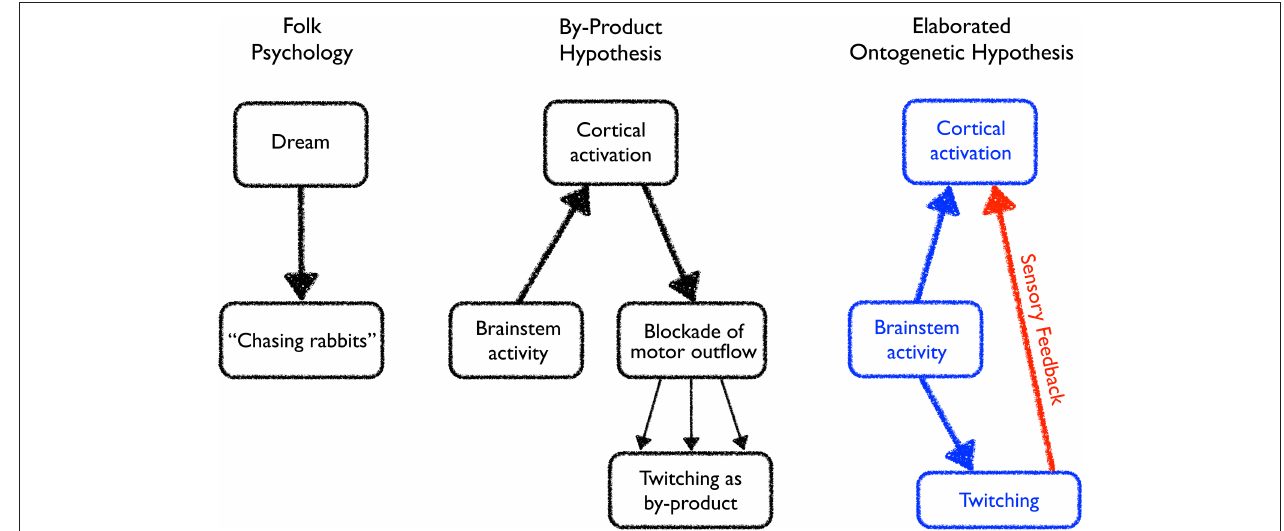
blockade of the motor outflow results in the production of twitching as a by-product of dream-related activity. Right: The ontogenetic hypothesis of Roffwarg et al. (1966), indicated in blue, posited a role for brainstem activity during active sleep in direct ascending activation of the cortex and descending activation of the musculature. This hypothesis is elaborated here to include an additional component, indicated in red, whereby brainstem-initiated twitching of the limbs generates sensory feedback, thereby activating the cortex. In turn, the hippocampus is activated as well (not